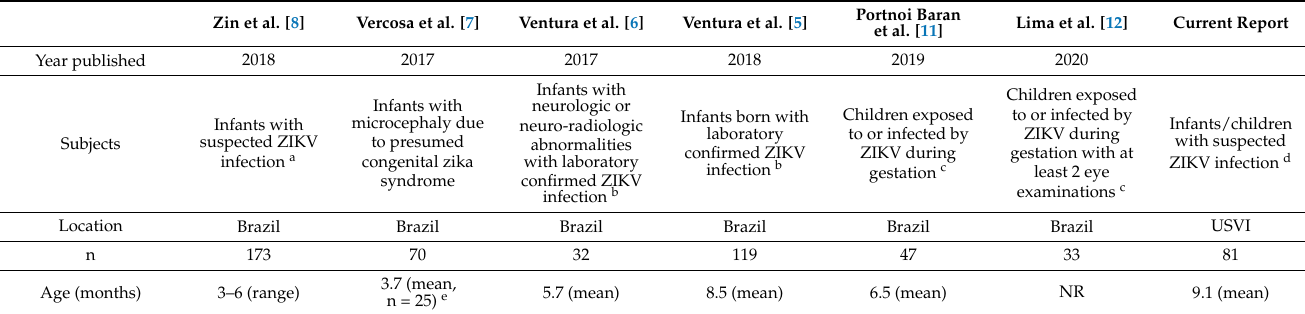
Table 5. Comparison of ocular findings and visual assessment among infants/children with suspected or confirmed antenatal zika virus (ZIKV) infection previously reported and in this